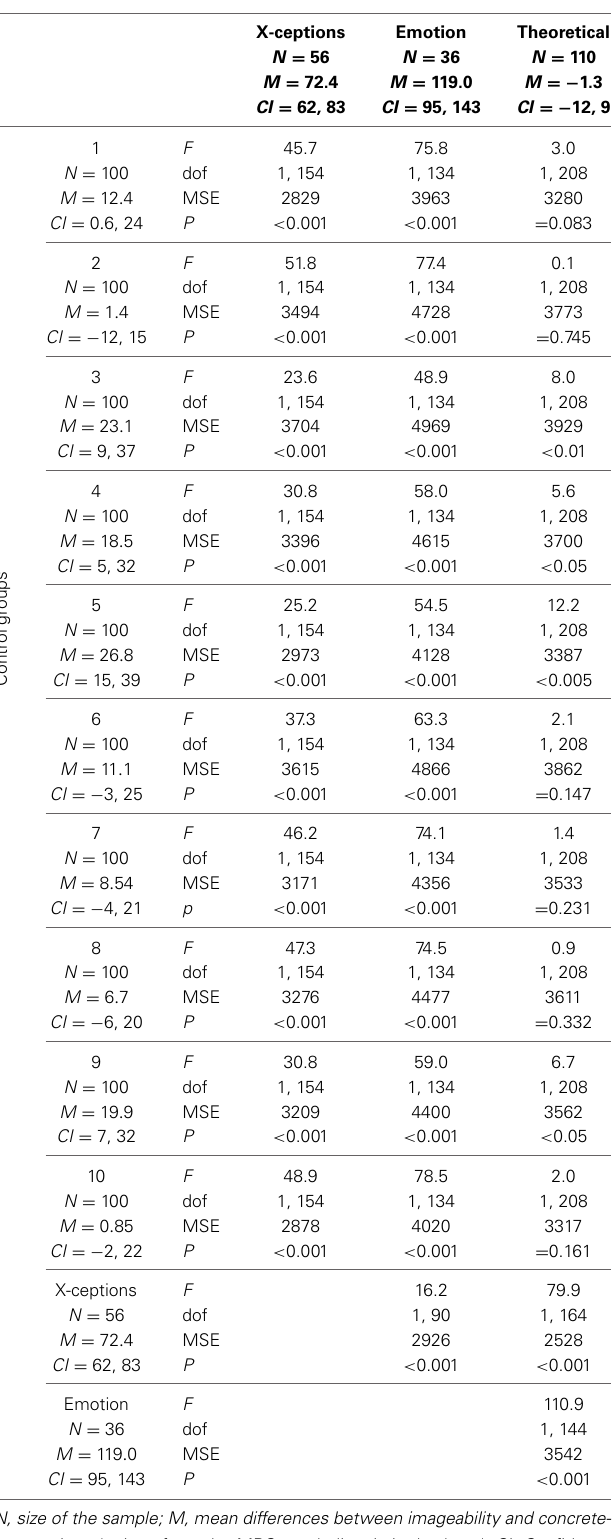
Table 1 | Results of the